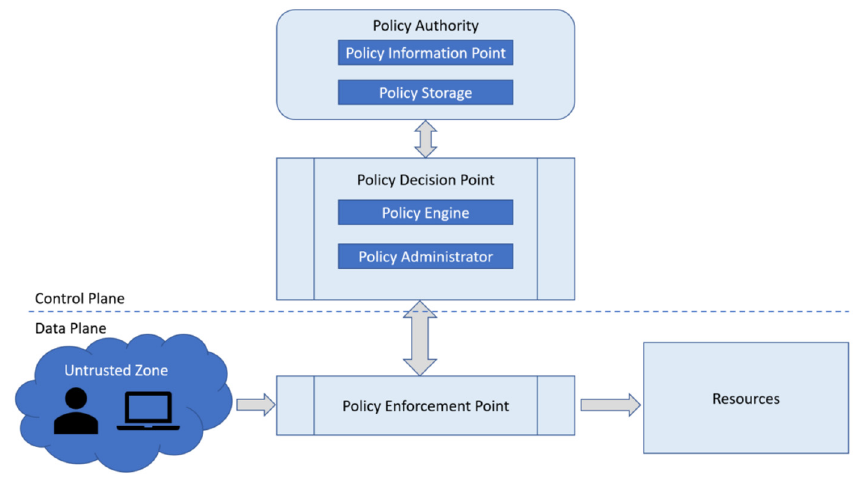
Figure 1. Zero-trust high-level architecture.